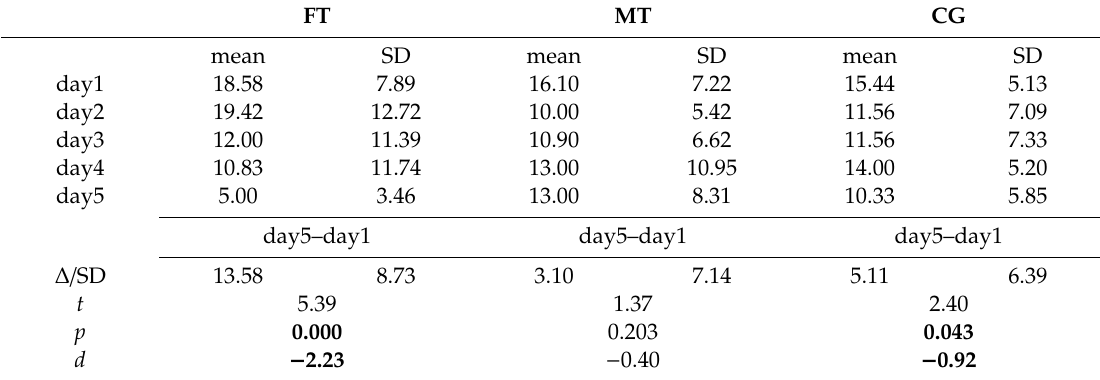
Table A1. Mean values and e ff ect sizes for Deck A within groups.